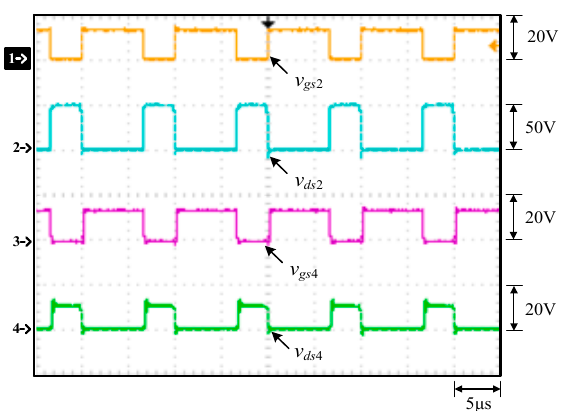
Figure 15. Measured waveforms at rated load: (1) v gs 1 ; (2) v ds 1 ; (3) v gs 3 ; (4) v ds 3.